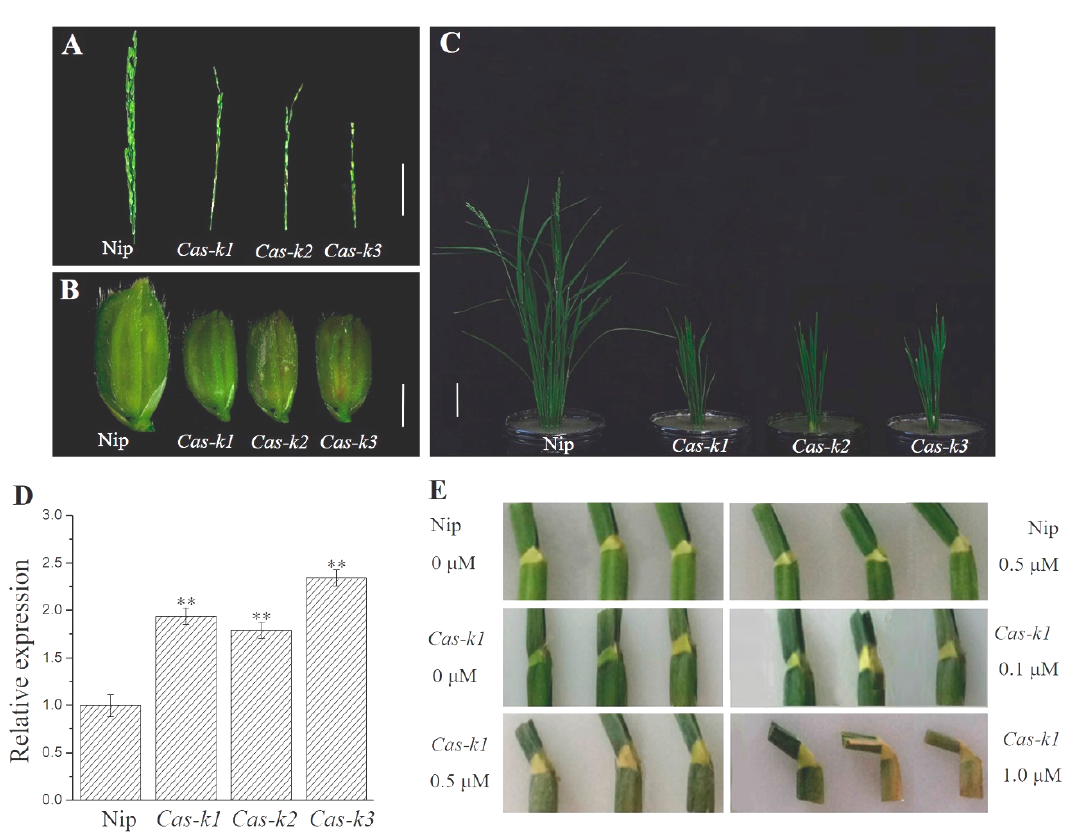
Figure 9. Phenotype analysis of three knock-out lines Cas-k1 , Cas-k2 and Cas-k3 . ( A ) The morphological analysis of panicles of knock-out lines. Bar = 5 cm; ( B ) The morphological analysis of spikelets in knock-out lines. Bar = 2 mm; ( C ) Plant phenotype of knock-out lines. Bar = 10 cm; ( D ) The expression levels of LTBSG1 in the young panicles of knock-out lines; ( E ) Sensitivity test of lamina joints to 24-EBL in knock-out line cas-k1 . Values represent the means ± SD of three biological replicates ( n = 3). ** p <